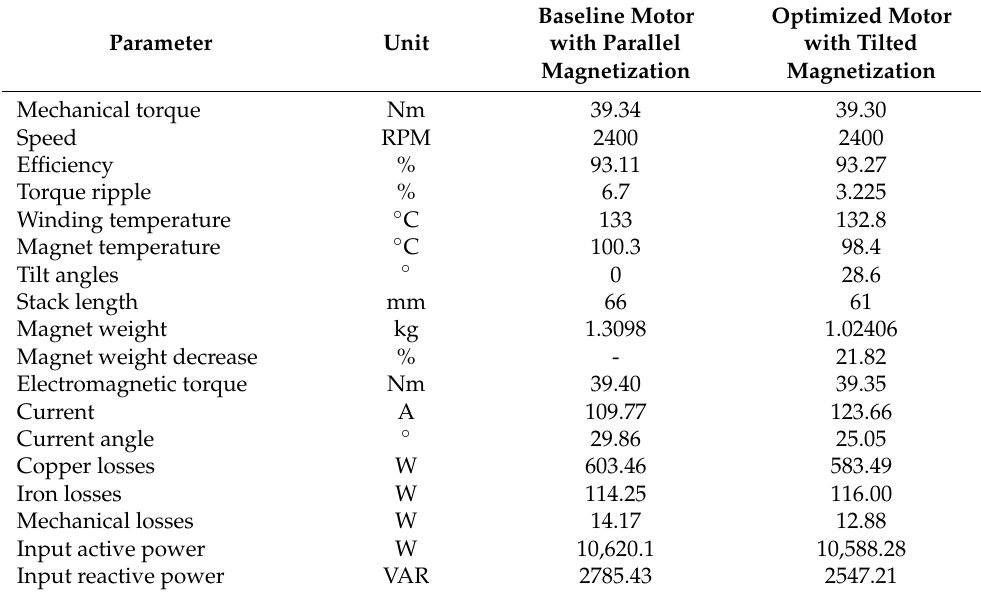
Figure 17. Less rare-earth motor selected candidate ( a ) Motor 2D view; ( b ) No-load flux density distribution. Table 8. Performance comparison of same operating point performance between the baseline motor of Figure 1 with parallel magnetization and the selected candidate with tilted